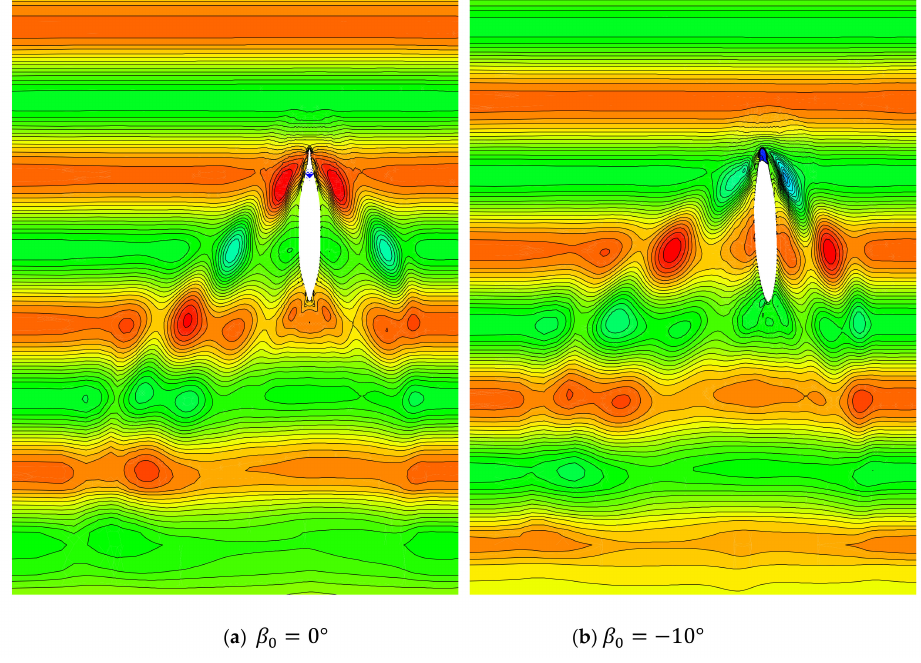
Figure 14. Wave snapshots for S-175 in head waves λ (cid:48) =